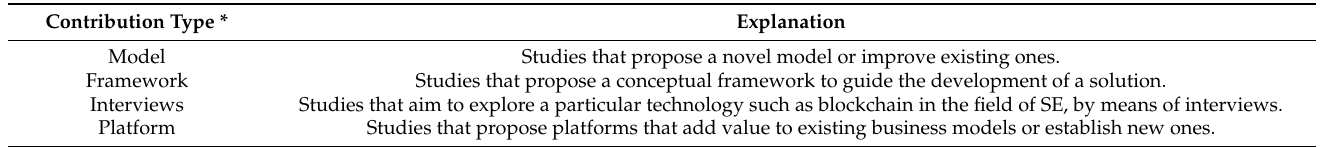
Table 4. Contribution Types.